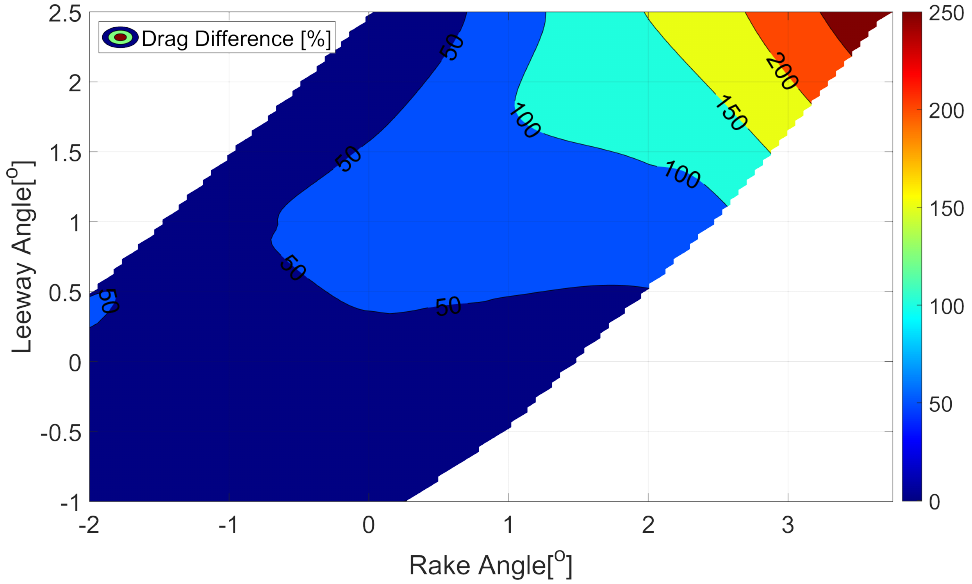
Figure 34. Difference between the computed and the measured drag force at 9 m/s, dimensions are in